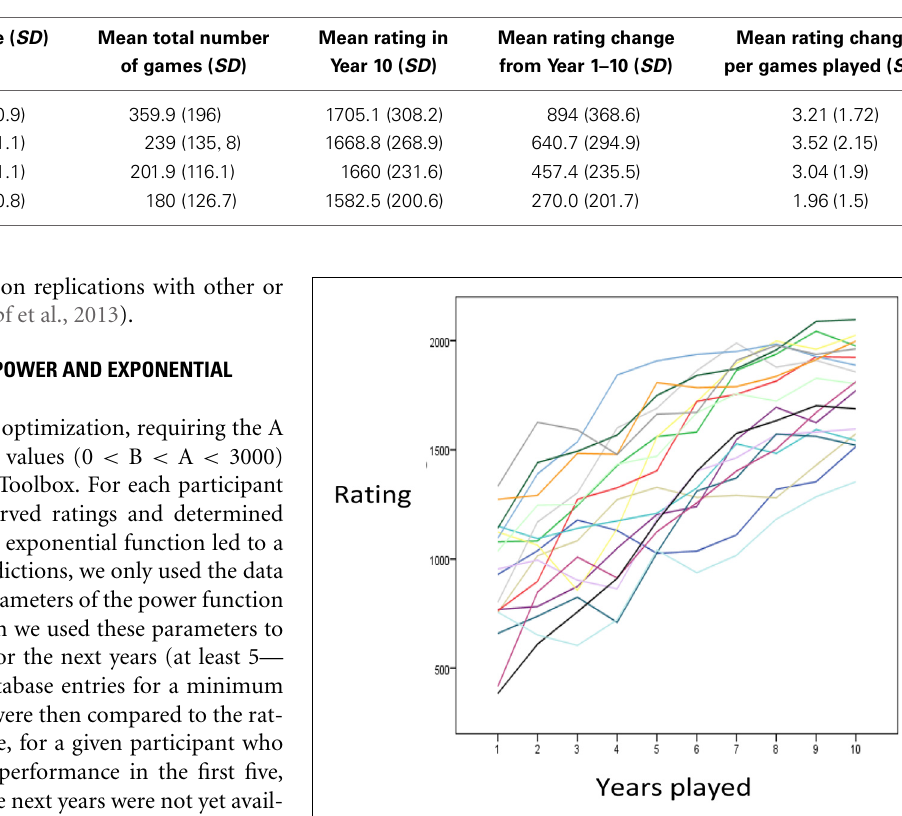
Table 2 | Sample characteristics and summary statistics on games played and ratings.